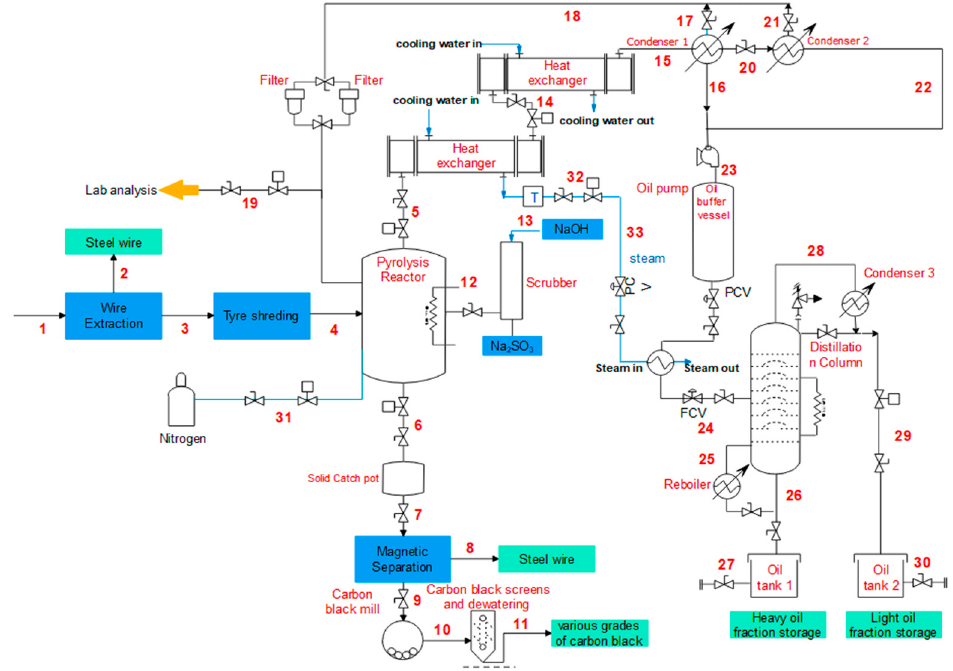
Figure 3. Pyrolysis process piping and instrumentation diagram.